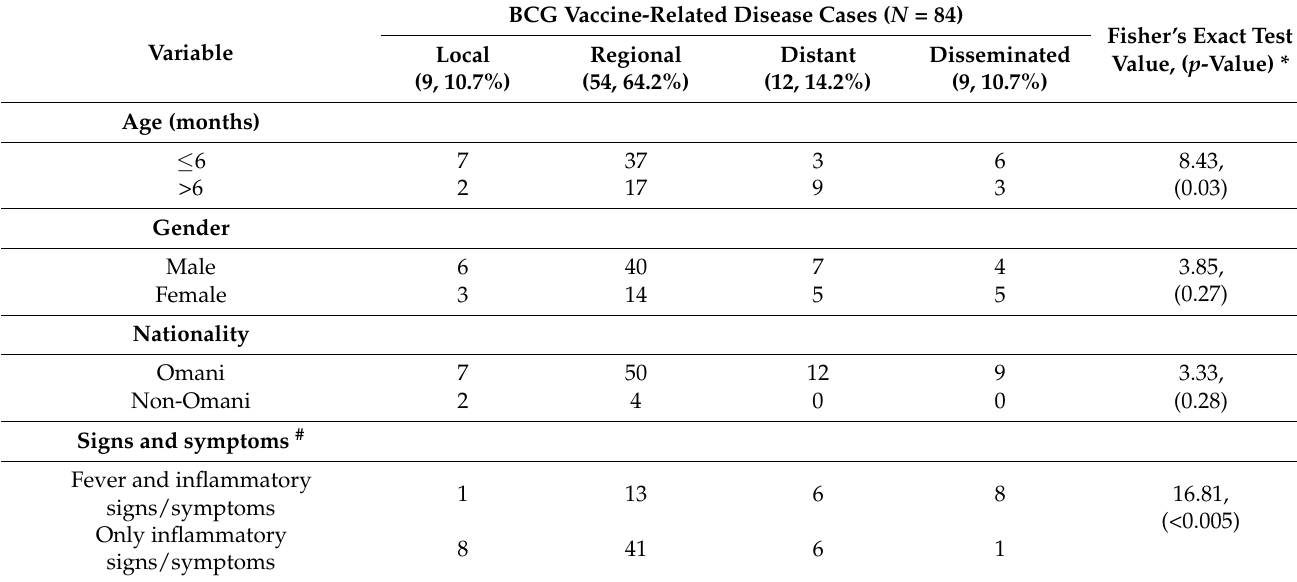
Table 1. Descriptive statistics of BCG vaccine-related disease cases according to gender, nationality, signs, and symptoms.